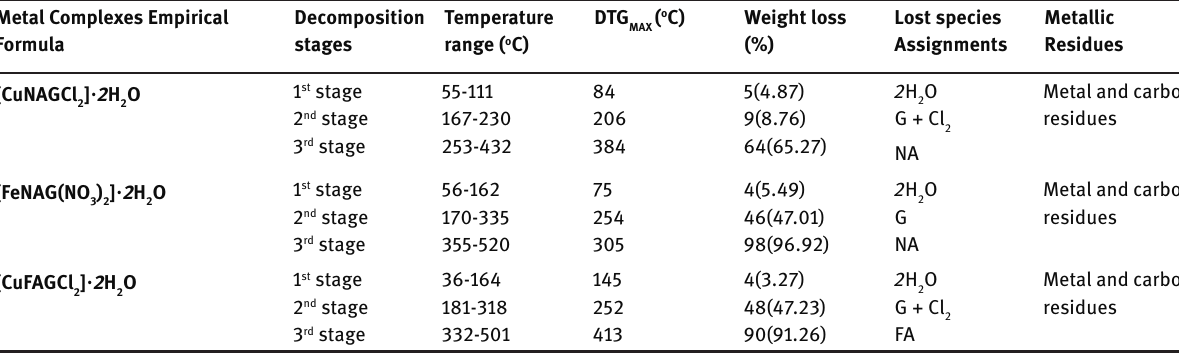
Table 4: TGA/DTG analysis of mixed glycine (G) – vitamins (NA/FA) – metal drug complexes. Metal Complexes Empirical